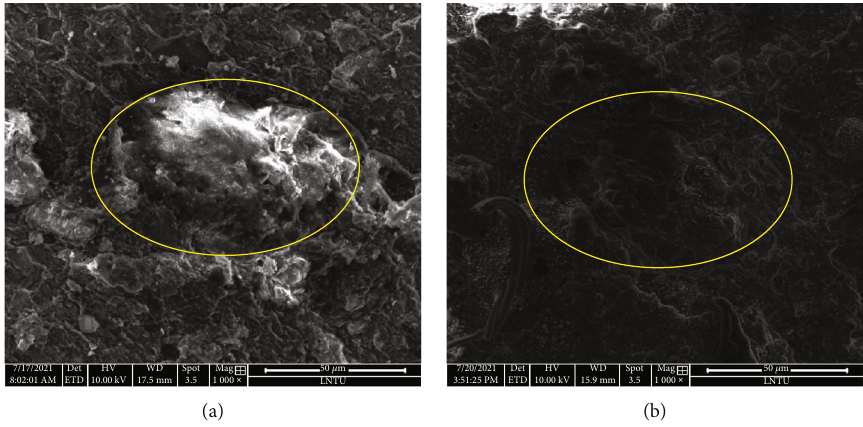
Figure 6: SEM image of oil shale at (a) 20 ° C and (b) 500 ° C at the same